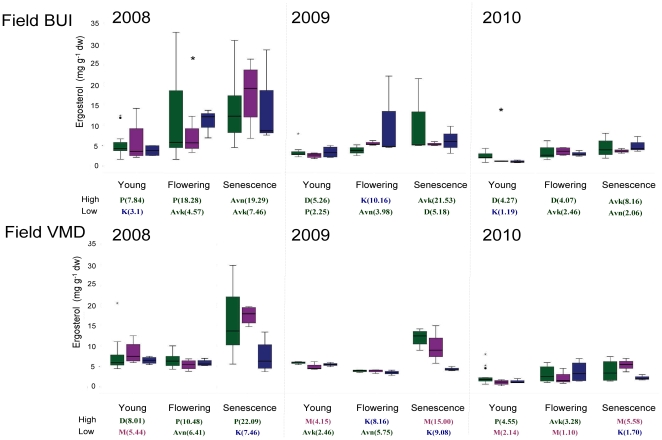
Change in fungal biomass.Boxplots of fungal biomass in the rhizosphere as measured by ergosterol concentrations during 3 years in different growth stages and in both field locations. The baseline (all other cultivars combined, n = 16) is marked with green boxplots, the GM-variety (n = 4) with purple and the parental variety ‘Karnico’ (n = 4) with blue markers. The star indicates a significant cultivar effect at the indicated time point. The values under the graphs are the cultivars with highest and lowest values (on average) colored the same as in the boxplots where ‘D’ = ‘Désirée’, ‘Avk’ = ’Aveka’, ‘Avn’ = ’Aventra’, ‘P’ = ‘Premiere’, ‘K’ = ‘Karnico’ (parental cultivar) and ‘M’ = ’Modena’ (modified cultivar).